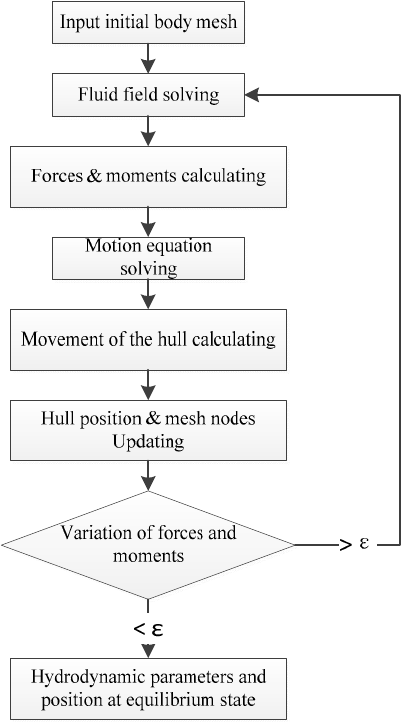
Figure 6. Solving procedure of the algorithm.